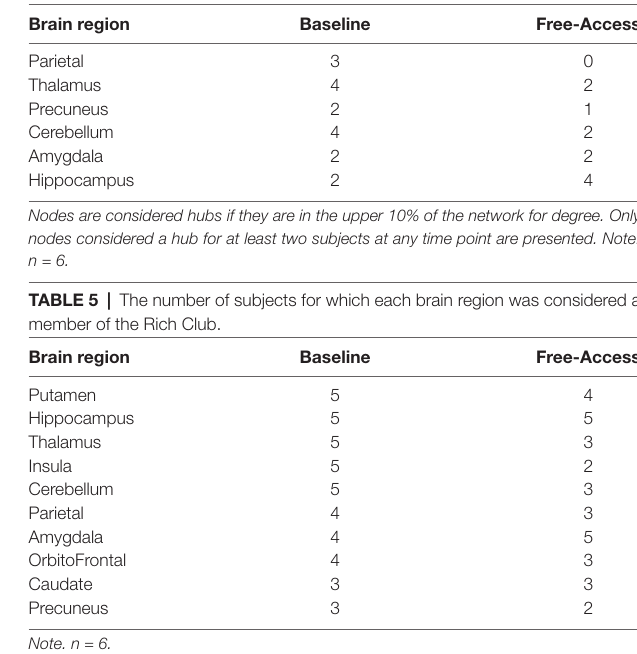
TABLE 4 | The number of subjects for which each brain region was considered a hub of the network.